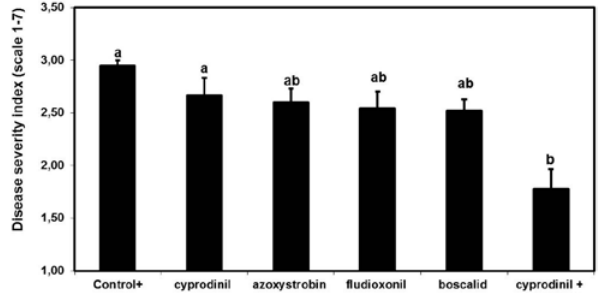
Figure 4 . Mean Aspergillus ear rot severity indices on field- grown maize plants artificially inoculated with Aspergillus flavus strain A6.10, and treated with different fungicides. Columns followed by different letters are significantly dif - ferent ( P≤ 0.05), according to Tukey’s HSD test. Vertical bars indicate standard errors of the means.